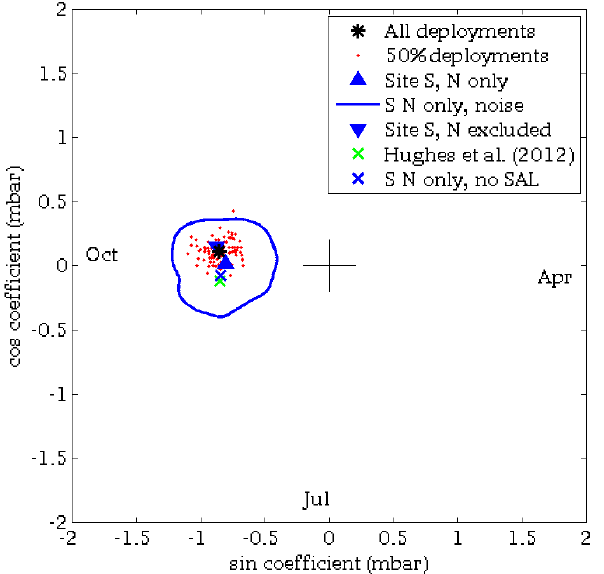
Figure 11. Spread of simultaneous results under bootstrapping (dots). Also the result for only sites 11 and 17 (S and N from pre- vious study) and excluding sites 11 and 17; the 95% noise contour for only sites 11 and 17; the result from Hughes et al. (2012); and only sites 11 and 17 with no self-attraction and loading correction to the ocean dynamics.